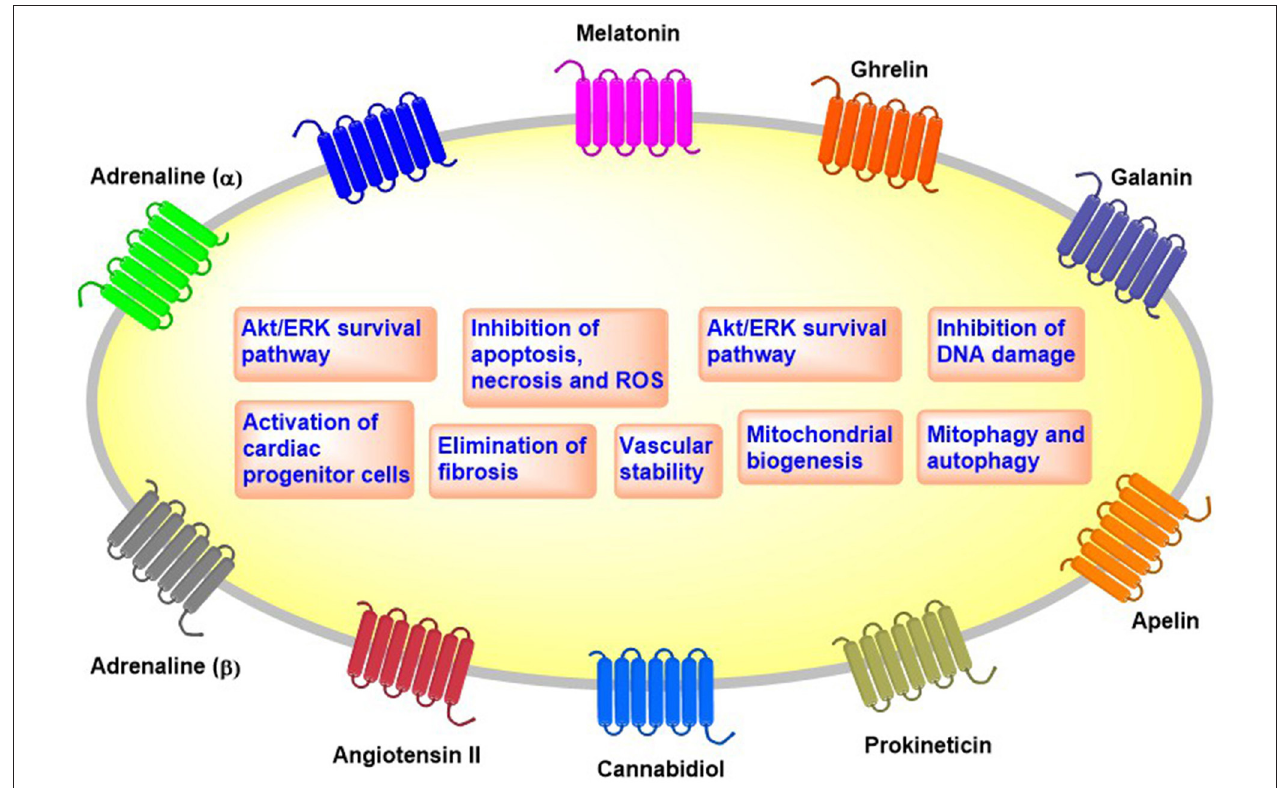
FIGURE 1 | Overview of the cellular effects of cardioprotective